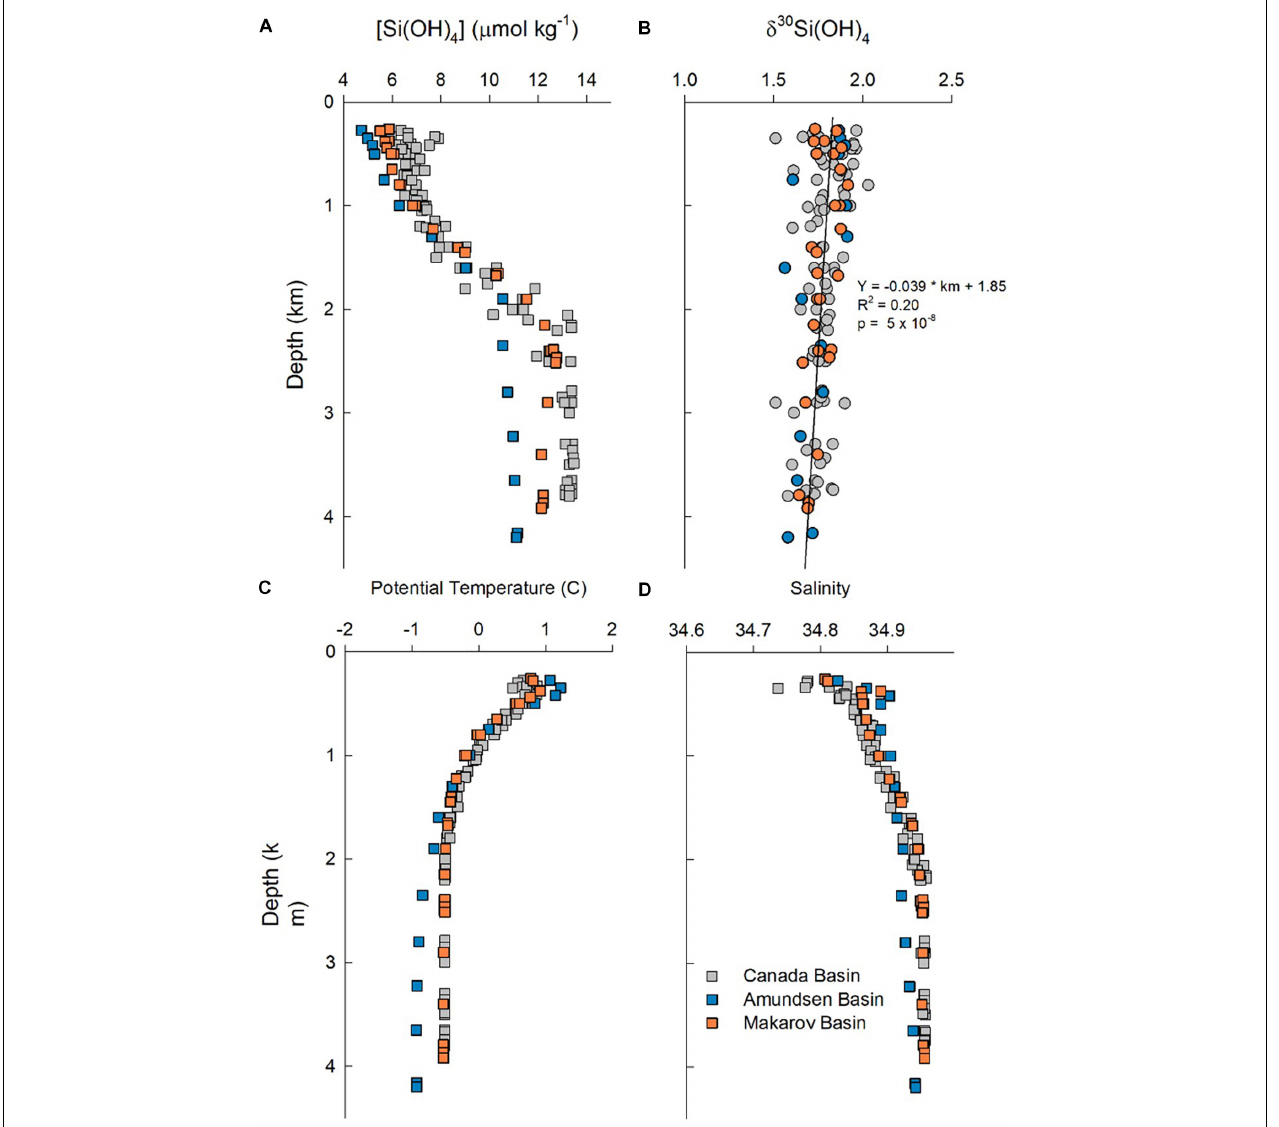
FIGURE 8 | Profiles of water column properties below 250 m. (A) Silicic acid concentration, (B) δ 30 Si(OH) 4 , (C) potential temperature, and (D) salinity. Colors denote stations in the Canada Basin (gray symbols), Makarov Basin (orange symbols), and the Amundsen Basin (blue symbols).